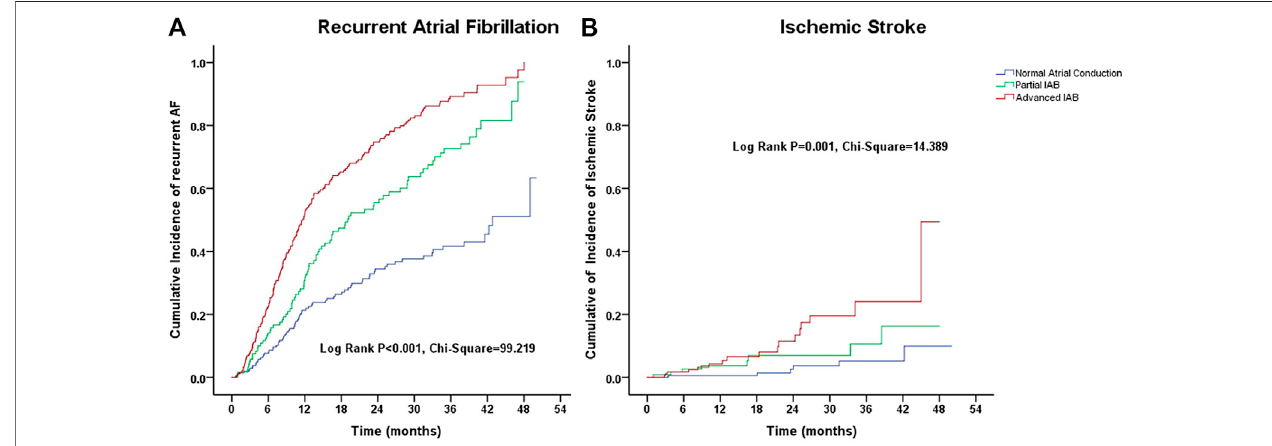
FIGURE2| Kalpana-Meierestimateofcumulativeincidencesof (A) recurrentatrial fi brillationand (B) ischemicstrokeaccordingtotheinteratrialblock(IAB)degree.